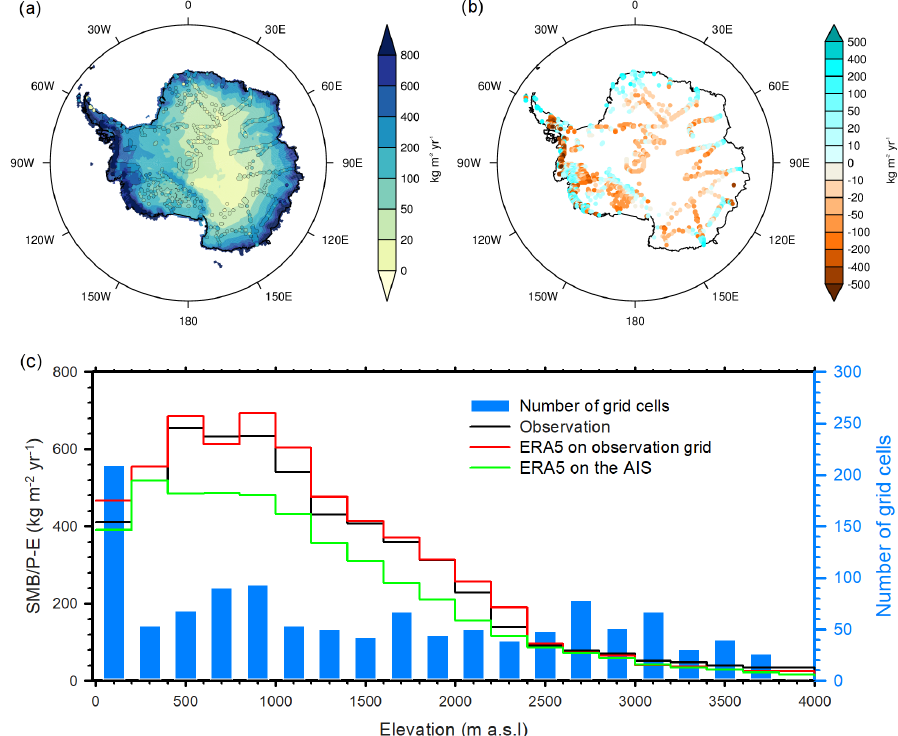
Figure 7. (a) Spatial distribution of ERA5 mean precipitation minus evaporation (approximated as SMB) for the period 1979–2018, and multi-year mean SMB measurements averaged on ERA5 grid cells (30km × 30km). (b) ERA5 minus observed SMB averaged on the ERA5 grid cells. (c) Multi-year-averaged observations and ERA5 simulations, binned in 200m elevation intervals. The number of ERA5 grid cells with in situ measurements in each elevation bin is shown by the blue line (right axis). Red lines denote SMB averaged by ERA5 for grid cells including observations within each elevation bin. Green lines denote SMB averaged by ERA5 over each whole bin of